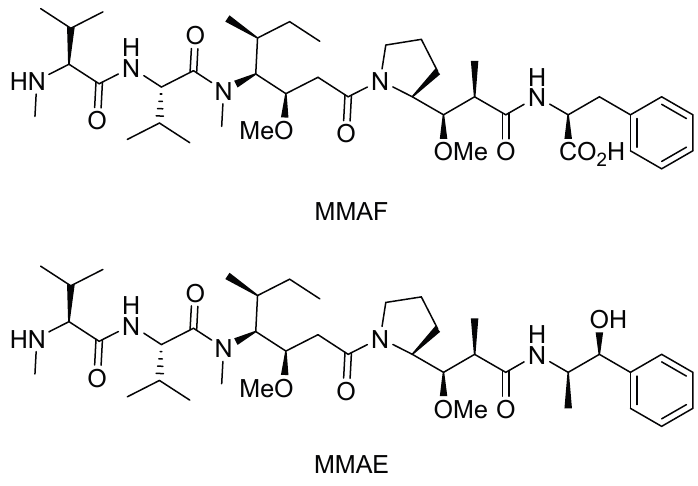
Figure 4. The structural formulas of monomethyl auristatin F (MMAF) and monomethyl auristatin E (MMAE). Adapted from Reference